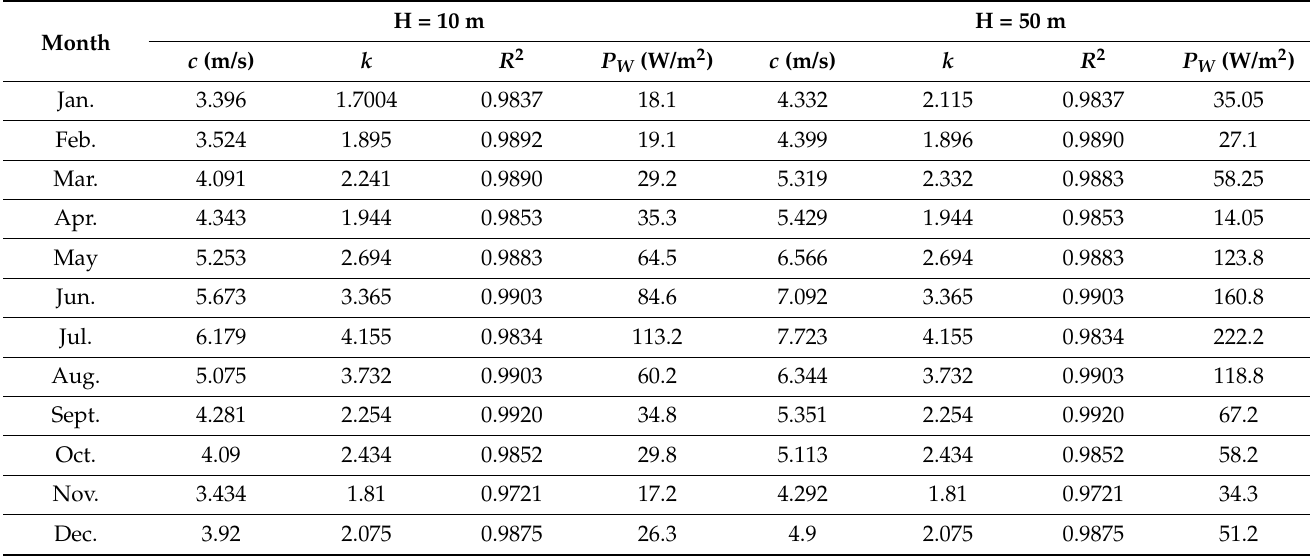
Table 9. The Weibull parameters by Mabchour’s Method (MMab), R 2 , Pw for RAWA city at 10 m and 50 m height, 2017.